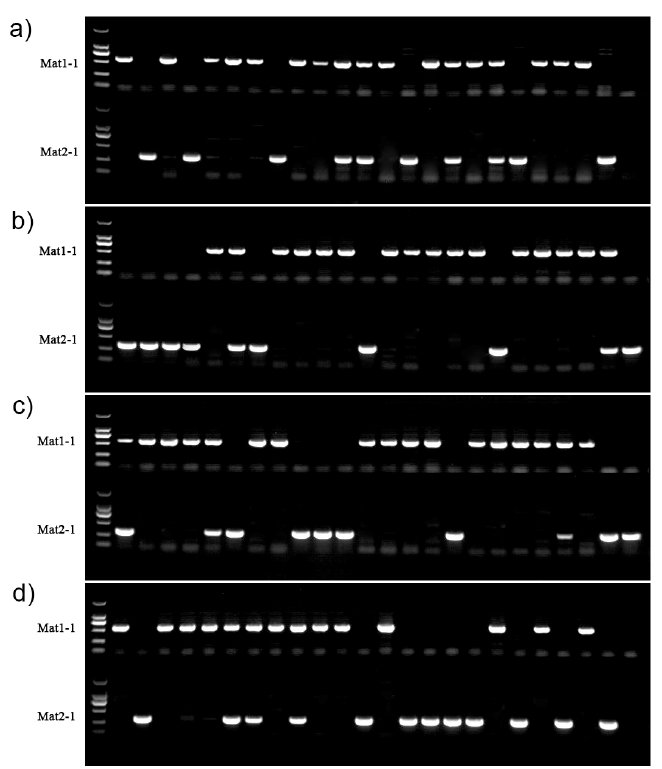
Figure 6. Genotyping results of the mating type of 94 germinated strains of M. sextelata . The leftmost lane of all pictures ( a – d ) was the DL2000 molecule marker. ( a ) Lanes 2 to 9 represent the 8 strains of the AH series and lanes 10 to 23 represent the 15 strains of the AF series. ( b , c ) Lanes 2 to 24 and lanes 2 to 23 ( d ) represent the 71 strains of the AI series. Mat1-1 and Mat2-1 represent two different mating genotypes.